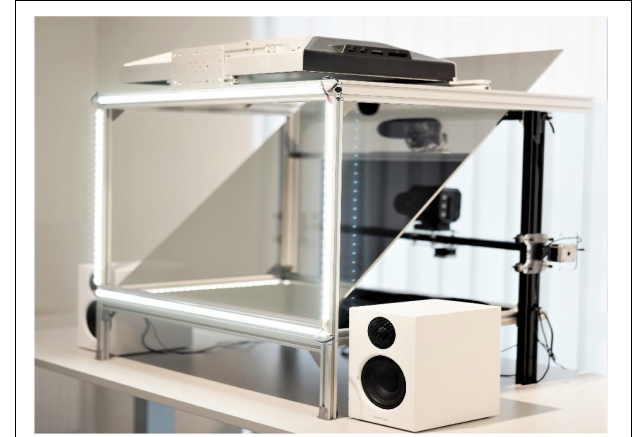
FIGURE 1 | The NUNA setup.